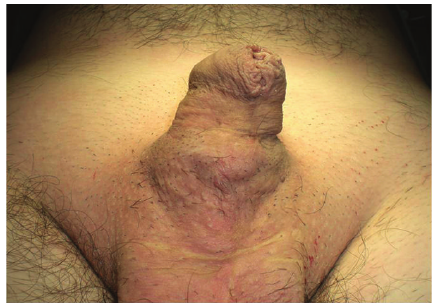
Figure 4: Case 2: removed hairballs.